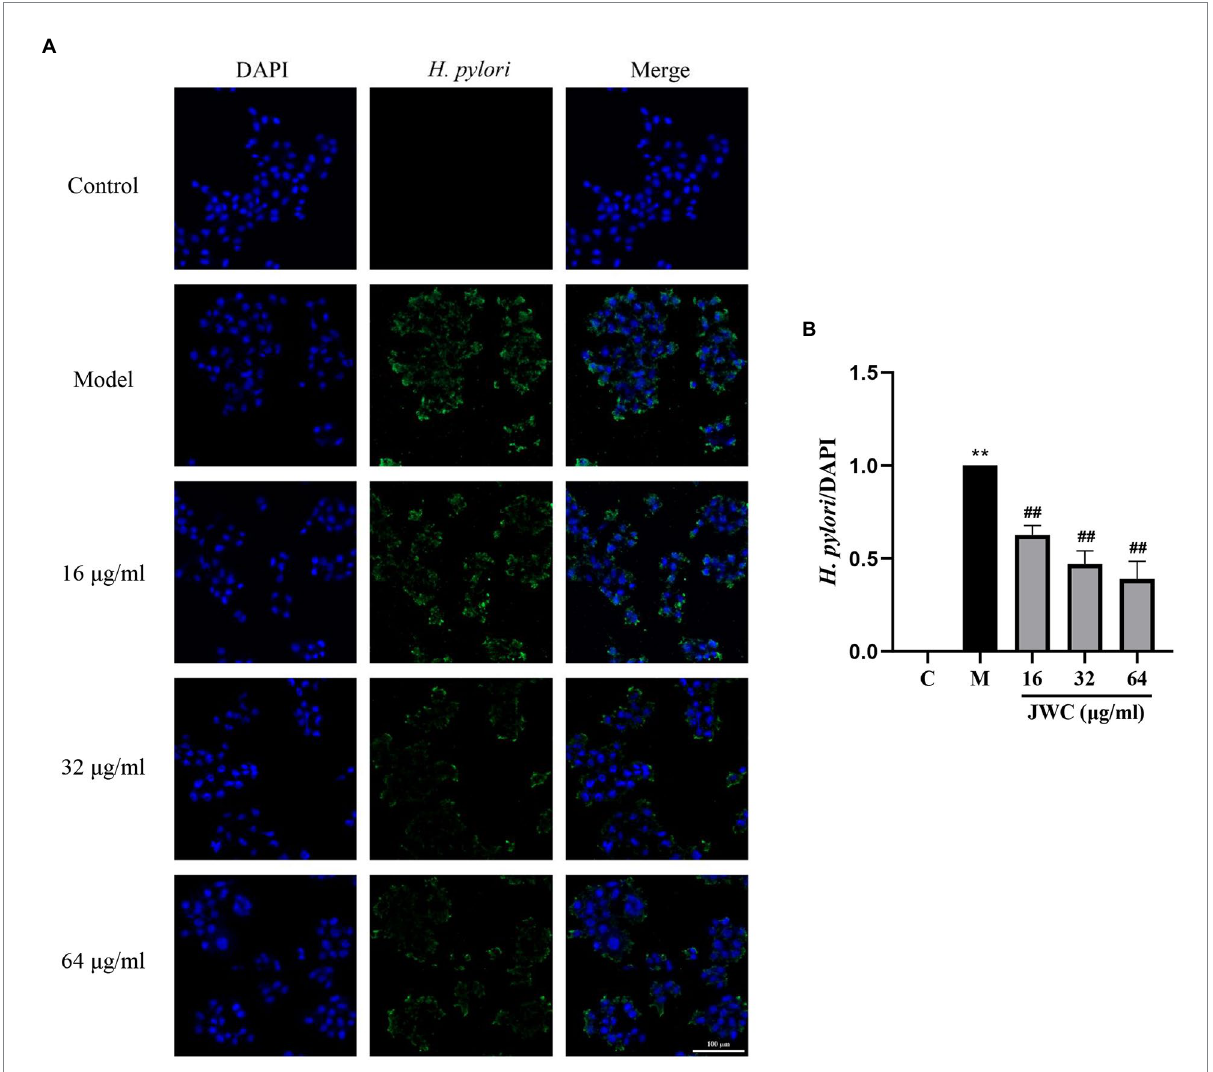
FIGURE 7 Effect of JWC on the adhesion of H. pylori 26,695–16R to GES-1 cells. (A) Immunofluorescence images of H. pylori and GES-1 adhesion after JWC intervention. Control group, only GES-1 cells; Model group, GES-1 and H. pylori . (B) The H. pylori fluorescence area/DAPI fluorescence area calculated by ImageJ software. ** p < 0.01, compared with the results of the control group. ## p < 0.01, compared with the results of the model group. Bold values represent a meaningful MIC change of antibiotic and the H. pylori strain used in subsequent